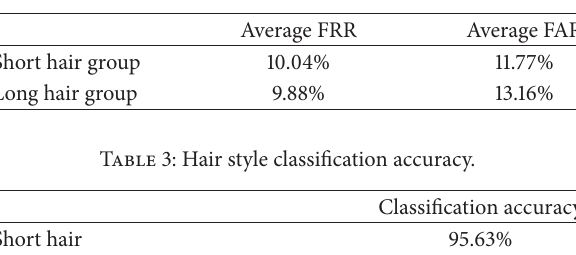
Table 2: Quantitative results of the algorithm proposed in [7].